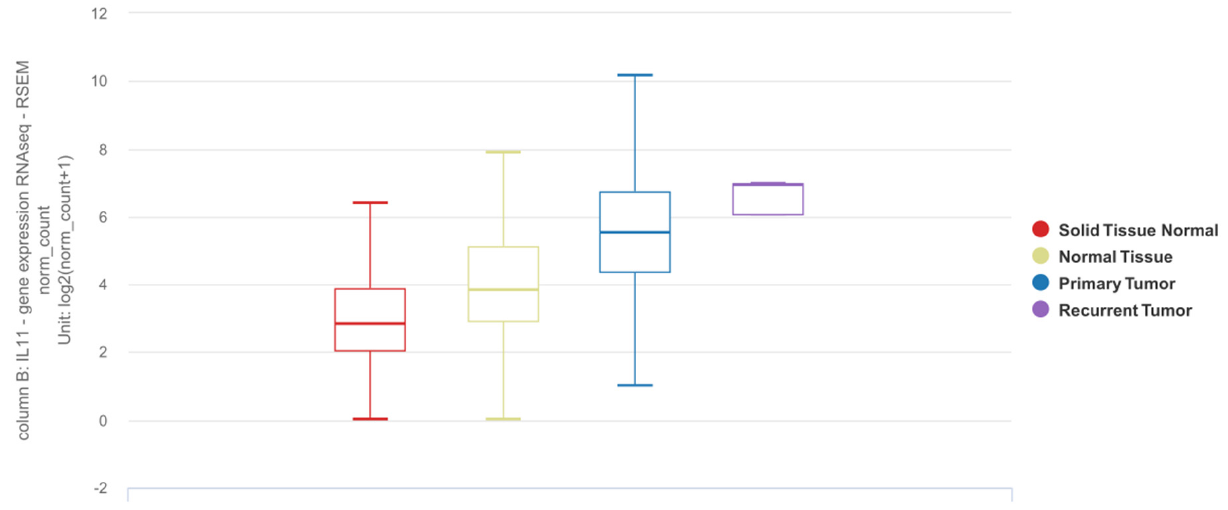
Figure 1. Differential expression of IL11 mRNA in lung adenocarcinoma (LUAD) and squamous cell carcinoma (SCC) based on the TCGA TARGET GTEx dataset. Solid tissue normal: adjacent normal tissue from TCGA dataset (n = 109). Normal tissue: tissue from subjects with no lung adenocarcinoma from GTEx dataset (n = 288). Primary tumor: lung tumor tissue (LUAD or SCC) from TCGA dataset (n = 1011). Recurrent tumor: lung tumor tissue from recurrence (n = 2). The results shown here are in whole or part based upon data generated by the TCGA Research Network [75] and GTEx [76] databases using the UCSC Xena online platform [77,78]. https://xenabrowser.net was accessed on 26 April